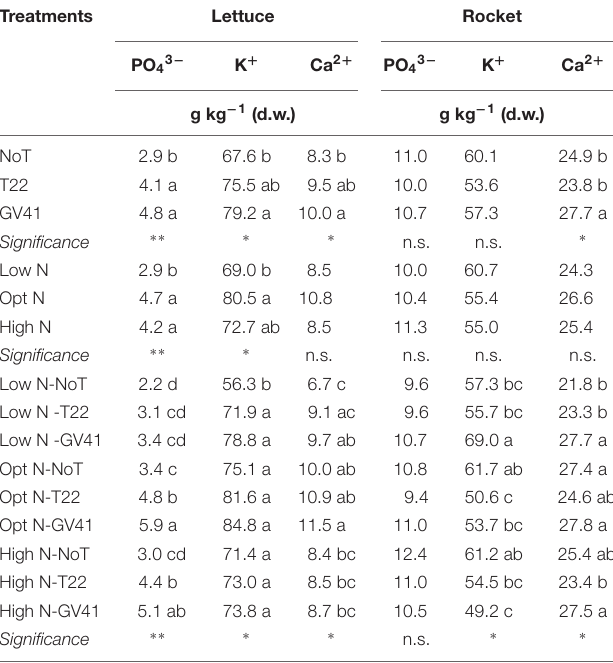
TABLE 1 | Analysis of variance and mean comparisons for mineral concentration of lettuce and rocket leaves grown with different N fertilization dose-sand inoculated with Trichoderma -based